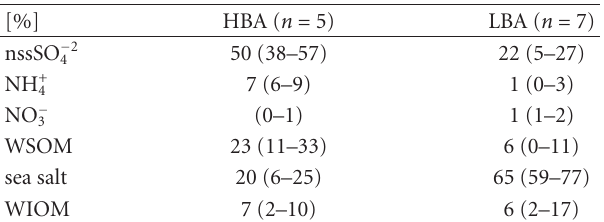
Table 1: Median, minimum and maximum (in brackets) relative contribution of the main marine aerosol components to the analyzed total mass, expressed as percentages. Median values are reported only when greater than zero. “ n ” indicates the number of